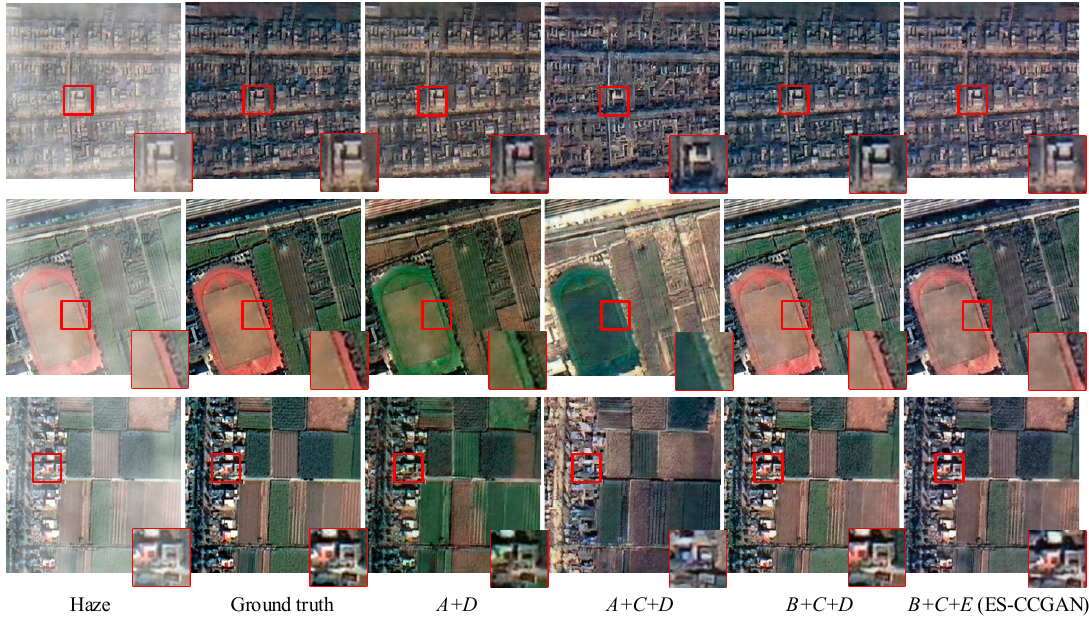
Figure 7. Dehazed results generated by the five factors: ‘Haze’ indicates the hazy image; ‘Ground truth’ is the haze-free image; ‘ A + D (CycleDehazing)’ is the model in [46]; ‘ A + C + D ’ is the improved cycle generative adversarial networks (CycleGAN) model by methods A , D , and C ; ‘ B + C + D ’ is the improved CycleGAN model by methods B , D , and C ; ‘ B + C + E (ES-CCGAN)’ is the proposed method.